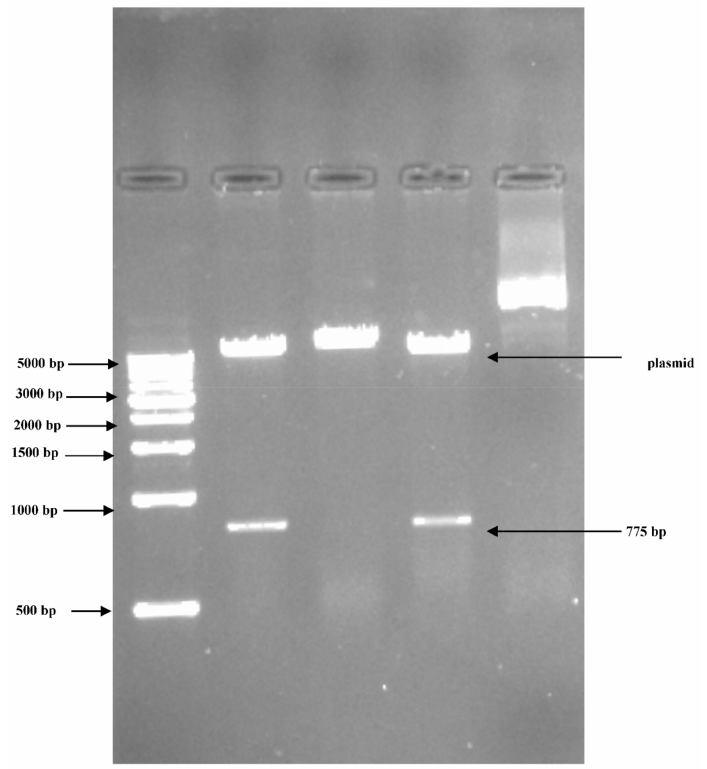
Figure 8. Agarose gel electrophoresis showing the PCR products after cloning into pSC-A vector using PCR system. PCR was performed on a recombinant Jojo-Gly I clone to verify the presence of Jojo-Gly I gene insert in a pSC-A vector. ( A ) Lanes (2, 3 and 5) show the expected size of the amplified PCR product using M13 universal primers, and ( B ) Lanes (1, 2, 4 and 6) show the expected size of the amplified PCR with specific primers by M13 and gly1r.